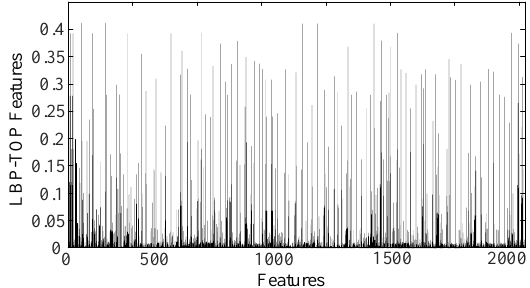
Figure 11. LBP-TOP texture feature diagram.